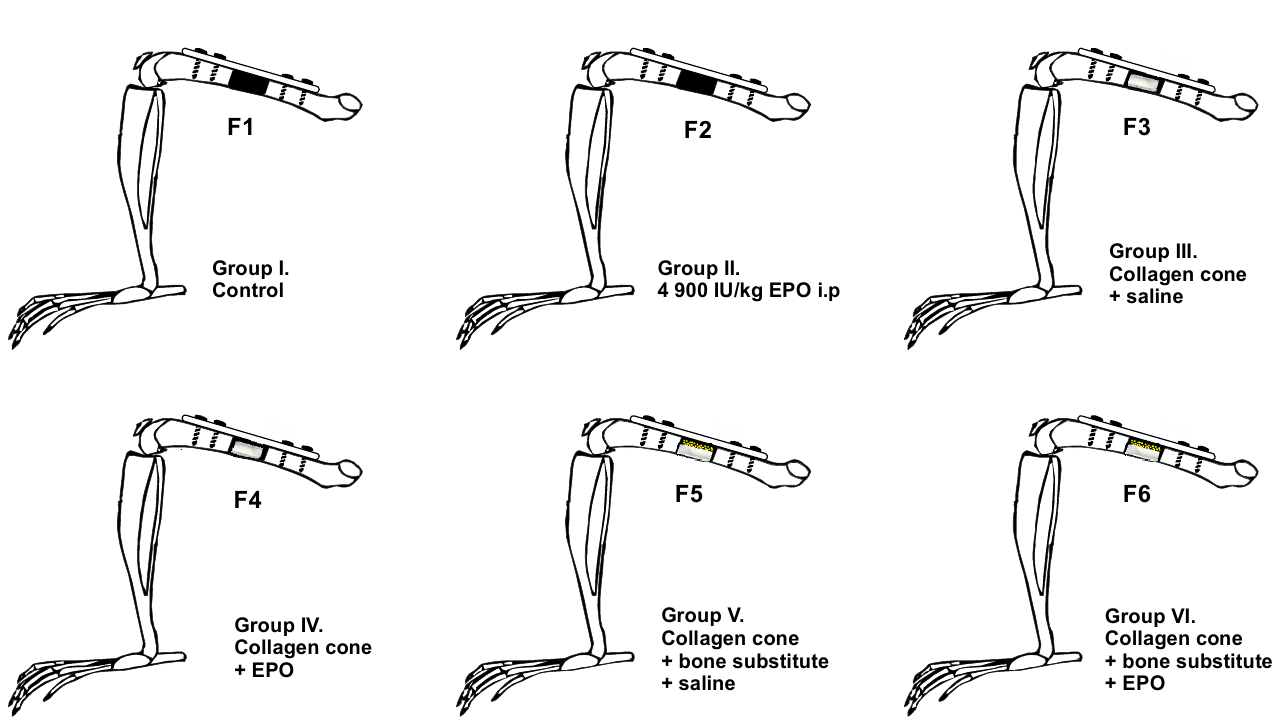
Figure 2. Experimental design: schematic presentation of groups and defects.